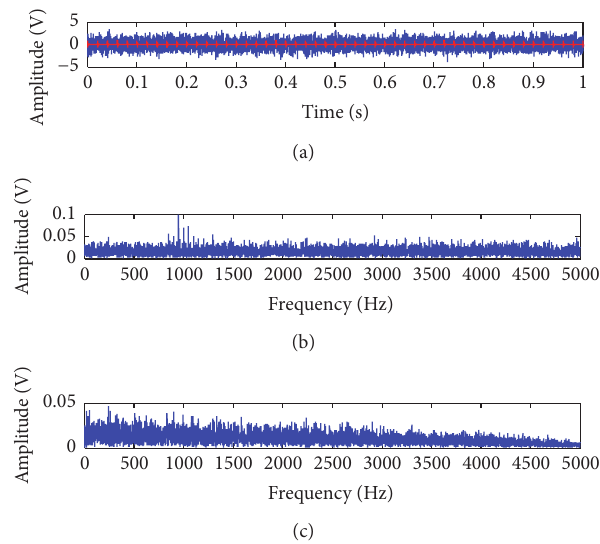
Figure 4: The noisy signal: (a) time-domain waveform; (b) fre- quency spectrum; (c) envelope spectrum.